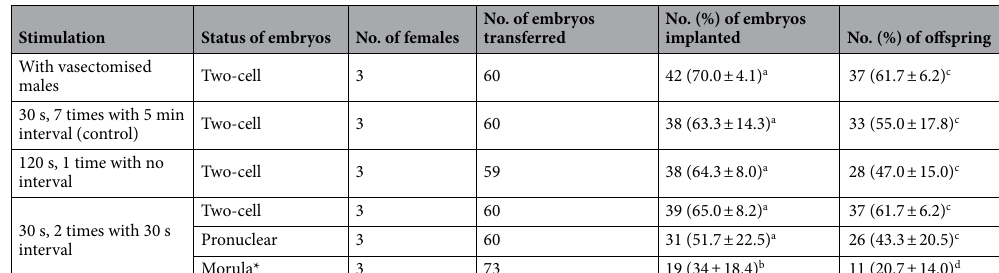
Table 1. The development of embryos transferred to females who were stimulated at the proestrus stage on the day before ET. Percentages were showed as the mean ± SD. ET embryo transfer. Significant differences at P < 0.05: a vs. b; c vs. d. *Transfer 92 h after stimulation at the proestrus stage.